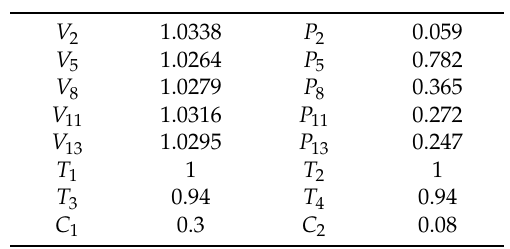
Table 7. The optimized system control parameters in Case B.